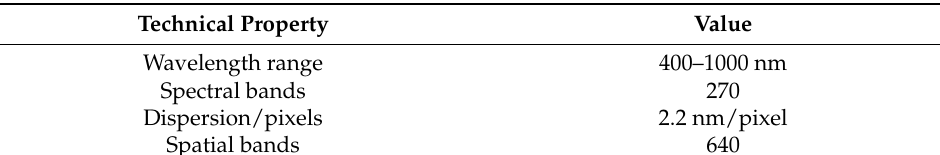
Table 1. Sensor configurations of the Nano-Hyperspec®.